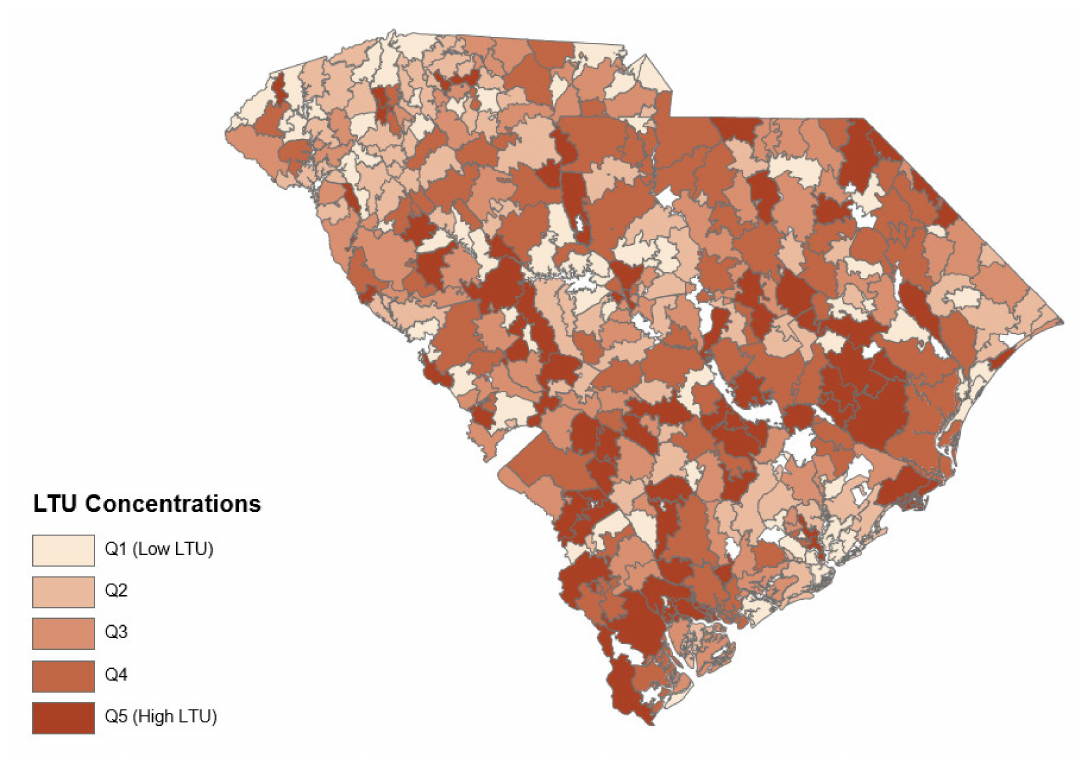
Figure 2. Geographical distribution of the Long-Term Uninsured (LTU) in South Carolina by Zip Code Tabulation Area. Table 1. Descriptive statistics of the ZCTAs and the top reasons for ED visit rates by uninsured patients across LTU quintiles, mean (standard